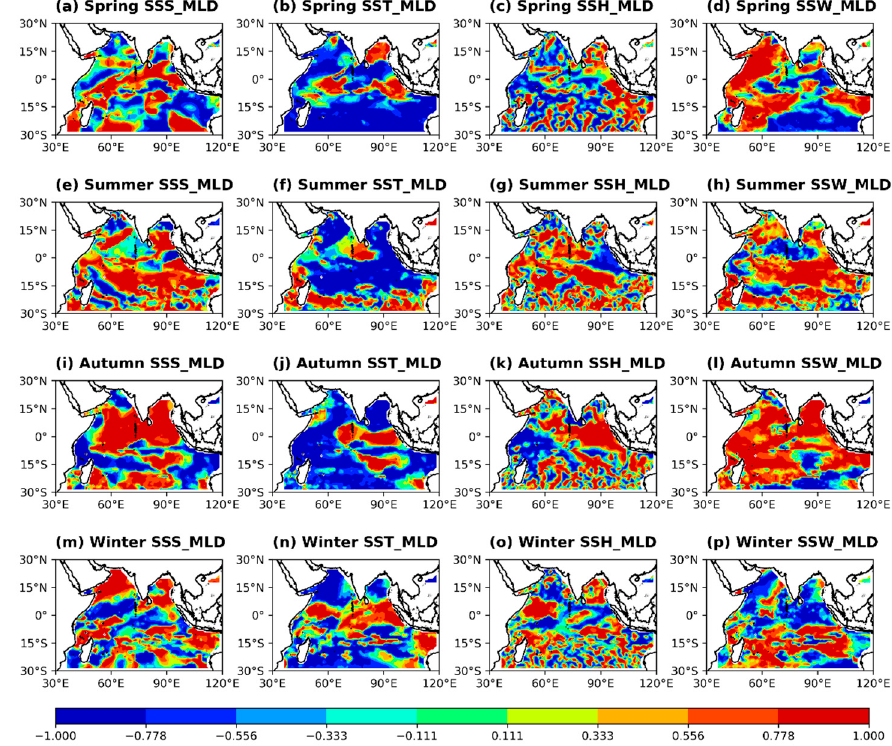
Figure 10. Spatial distribution of Pearson correlation coefficients between the estimated MLD and sea ‐ surface parameters (SST, SSS, SSH, and SSW).